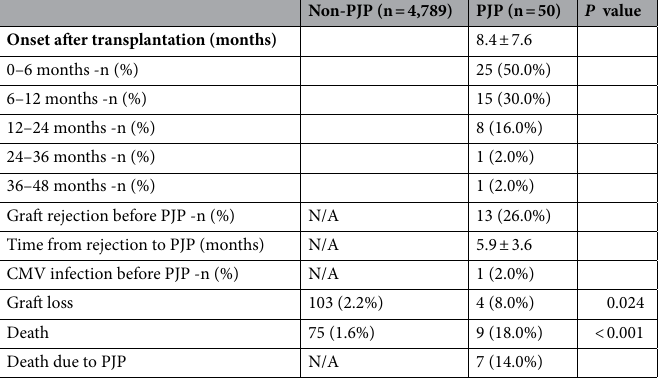
Table 2. Clinical characteristics and impacts of Pneumocystis jirovecii pneumonia on outcomes. Note: data are presented as mean ± standard deviation, or n (%). Abbreviations : CMV, cytomegalovirus; N/A, not applicable; PJP, pneumocystis jirovecii pneumonia.